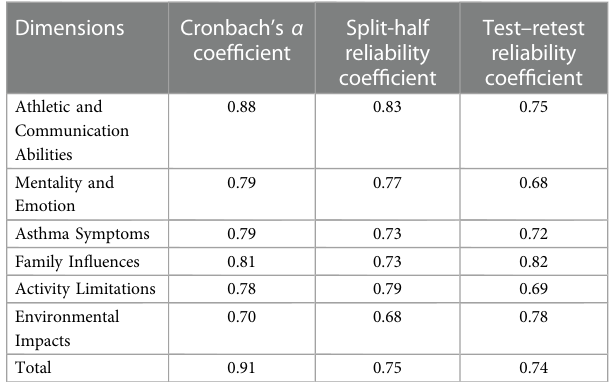
TABLE 3 Reliability coef fi cients of the fi nal asthmatic children patient reported outcomes questionnaire reported by caregivers in all dimensions ( n